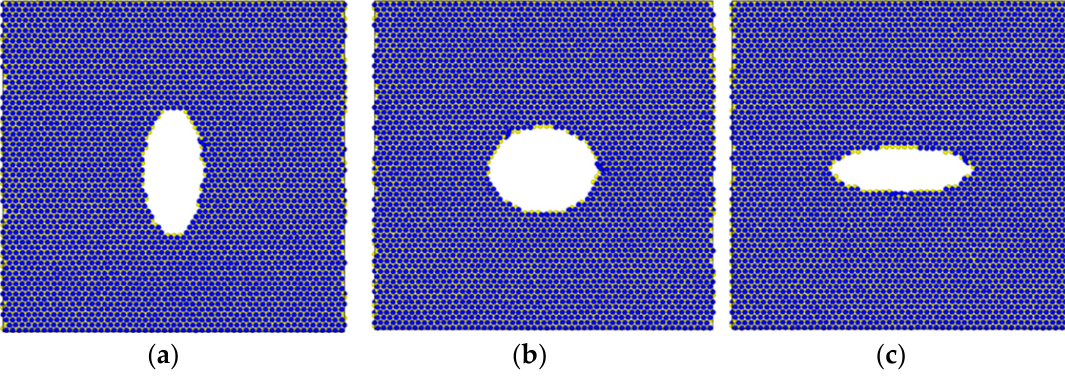
Figure 6. Monolayer MoS 2 nanosheet with void identified by optimization: ( a ) P ref11 = 180, P ref22 = 150 GPa ( g 1 = 15.35 Å and g 2 = 33.44 Å); ( b ) P ref11 = 160, P ref22 = 160 GPa ( g 1 = 28.12 Å and g 2 = 23.15 Å); ( c ) P ref11 = 150, P ref22 = 180 GPa ( g 1 = 36.35 Å and g 2 = 12.19 Å).